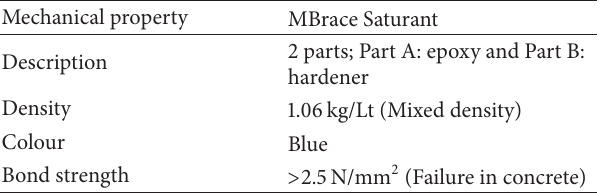
Table 3: Typical properties of MBrace